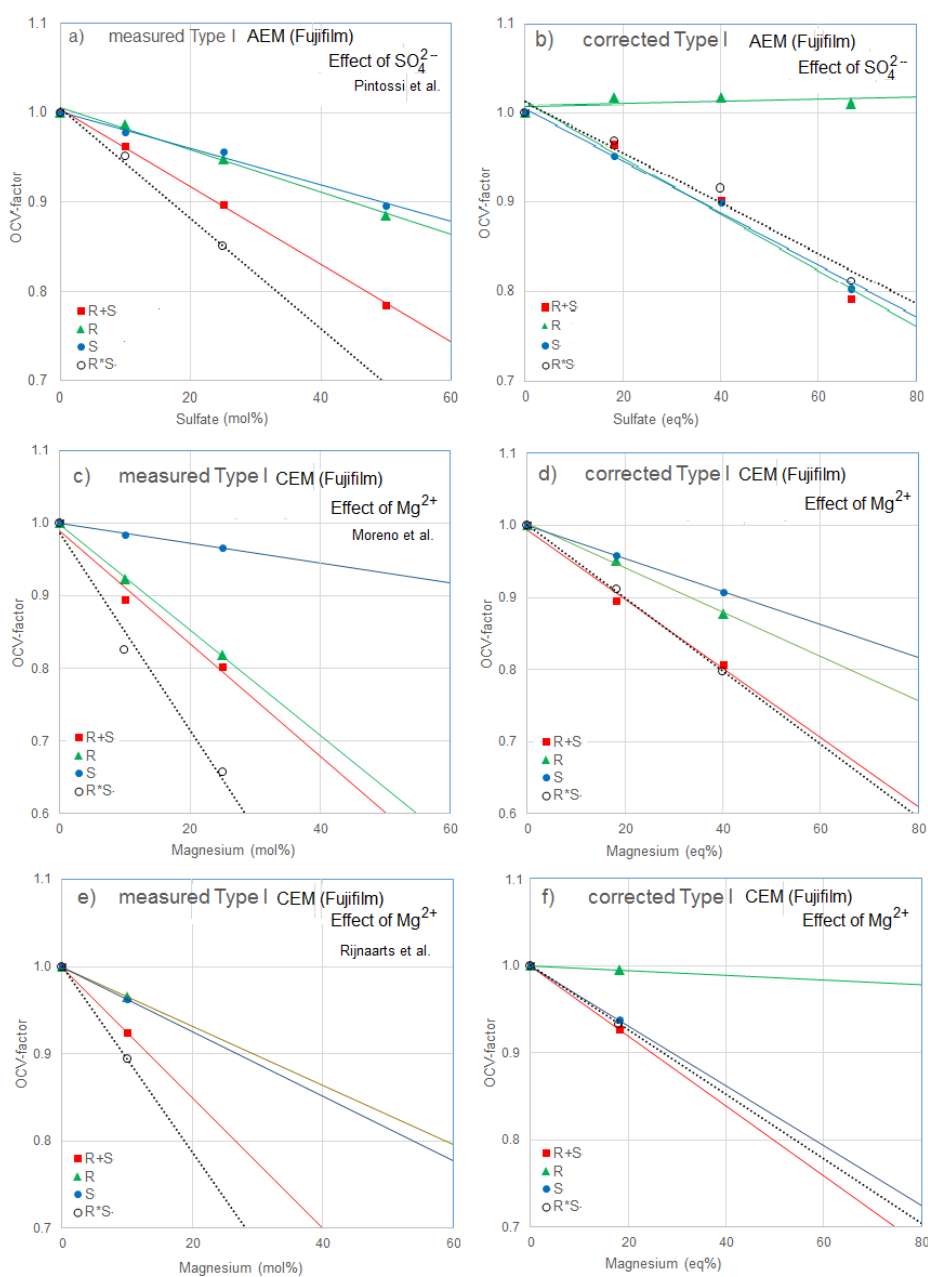
Figure 5. Effect of divalent ions on the OCV of cell pairs containing Type I AEM ( a , b ) and Type I CEM ( c , d , e , f ). Plots ( a , c,e ) were constructed from publications of Pintossi et al. [27], Moreno et al. [14], and Rijnaarts et al. [32]. By eliminating the effects induced by the changing monovalent ion concentrations, the corrected Figures ( b , d , f ) were constructed. In the legend, R refers to addition to river water, S to seawater, R+S to both feed waters and R*S to the calculated product of R and